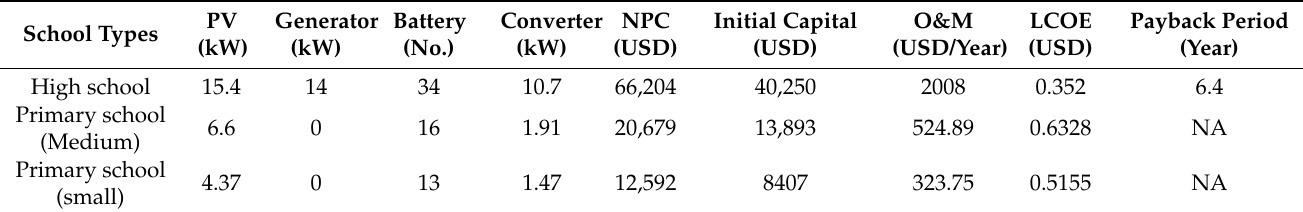
Table 7. Optimized combination of PV, generator, and battery for a hybrid system: operational and maintenance cost analysis.